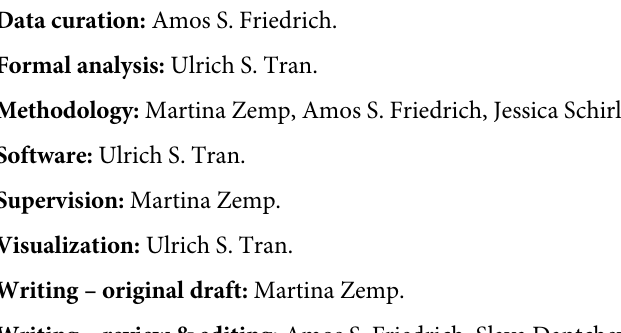
S2 Table. Study characteristics of included studies ( k = 47). S3 Table. Coded moderators of included studies ( k = 47). S4 Table. Quality assessment of included studies ( k =